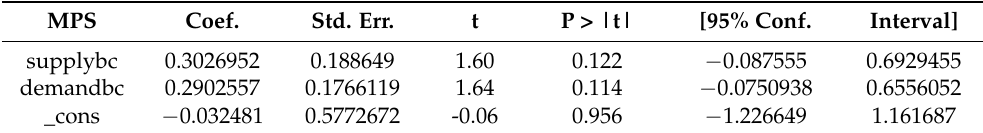
Table 3. Regression analysis before COVID-19 pandemic.